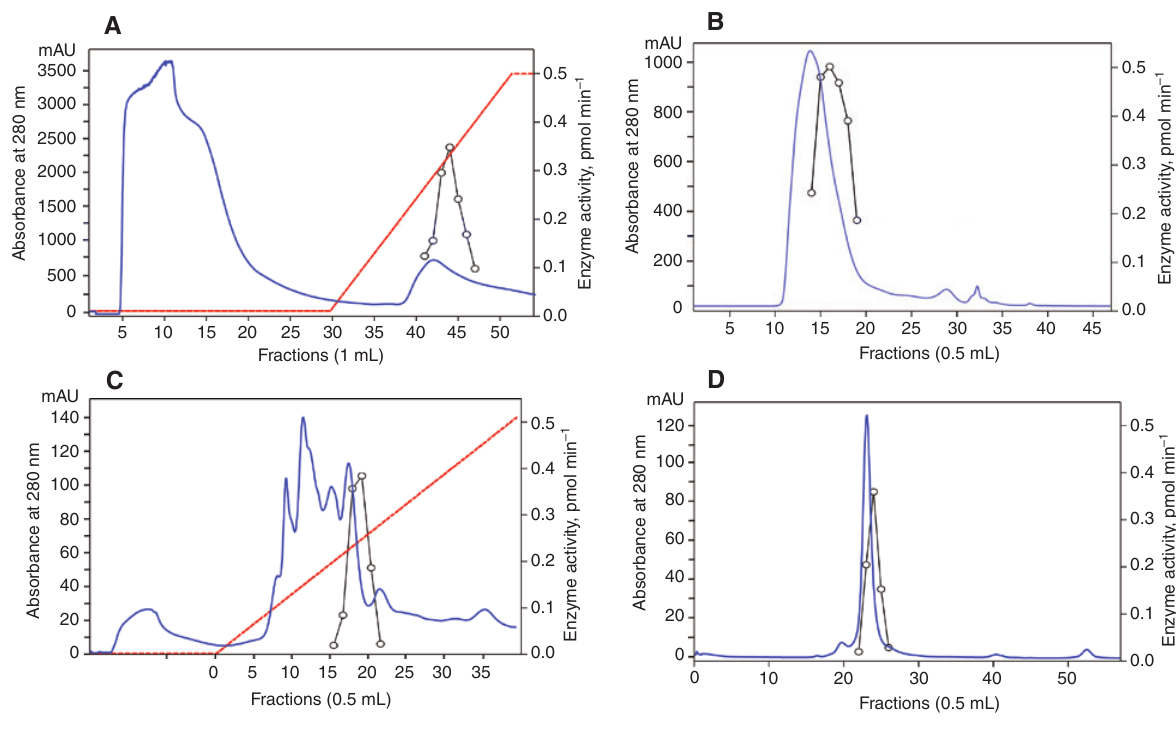
Figure 2: Purification of AlrA protein. (A) Affi-gel blue chromatography (1 × 6.7 cm) with a linear gradient of 0–500 mM NaCl. (B) Superdex 75 10/300 GL chromatography. (C) Mono Q 5/50 GL chromatography with a linear gradient of 0–150 mM NaCl. (D) Superdex 200 10/300 GL chromatography. Solid blue line, protein; open circle dark line, enzyme activity; dotted red line, salt gradient.